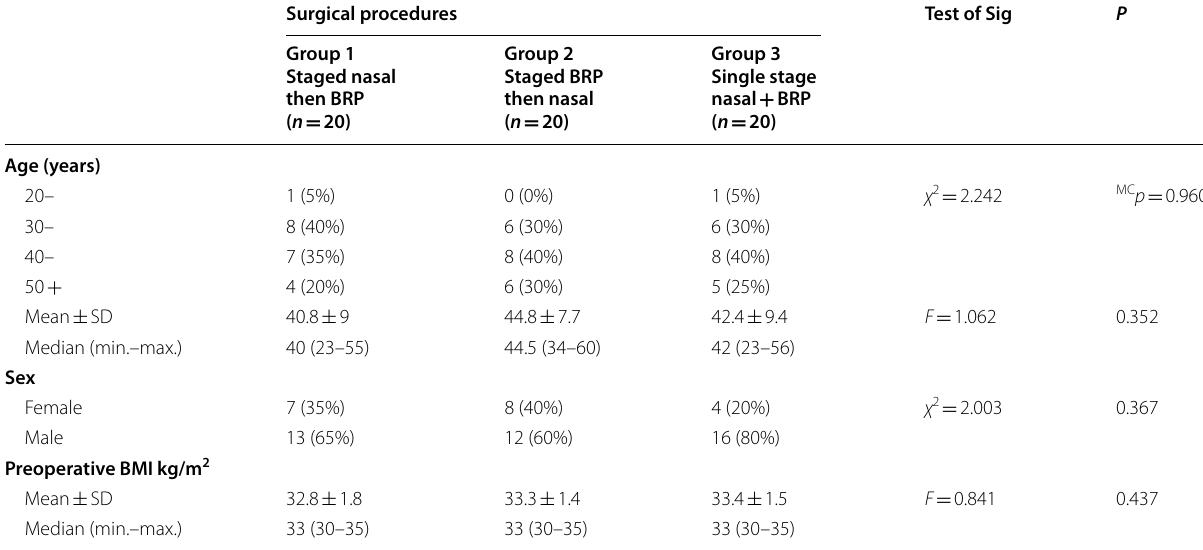
SD standard deviation, χ 2 chi-square test, MC Monte Carlo, F F for one-way ANOVA test, pairwise comparison bet. Each 2 groups was done using post hoc test (Tukey)